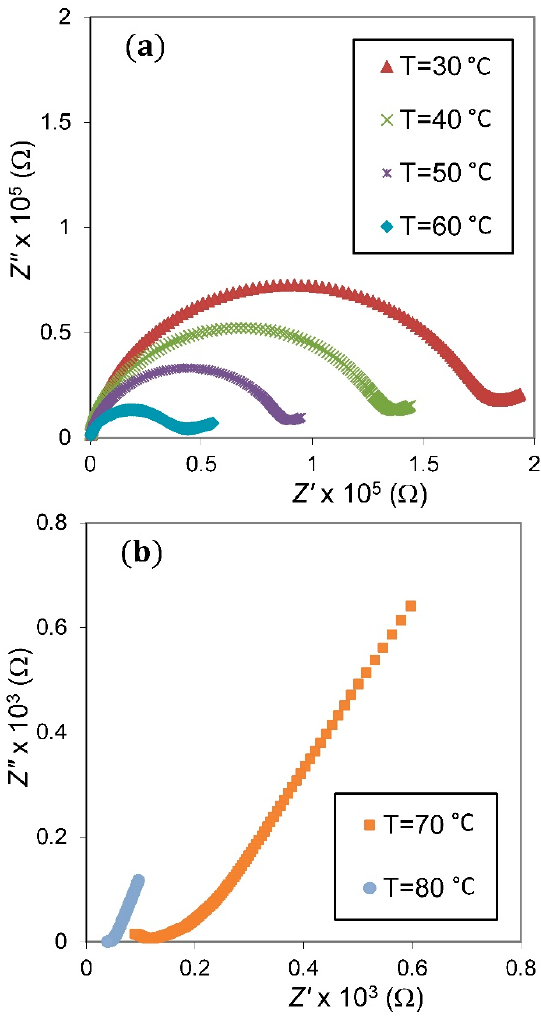
Figure 5. Impedance plot of the NSPE-2 sample at temperatures of 30 – 60 °C ( a ) and 70 – 80 °C ( b ).